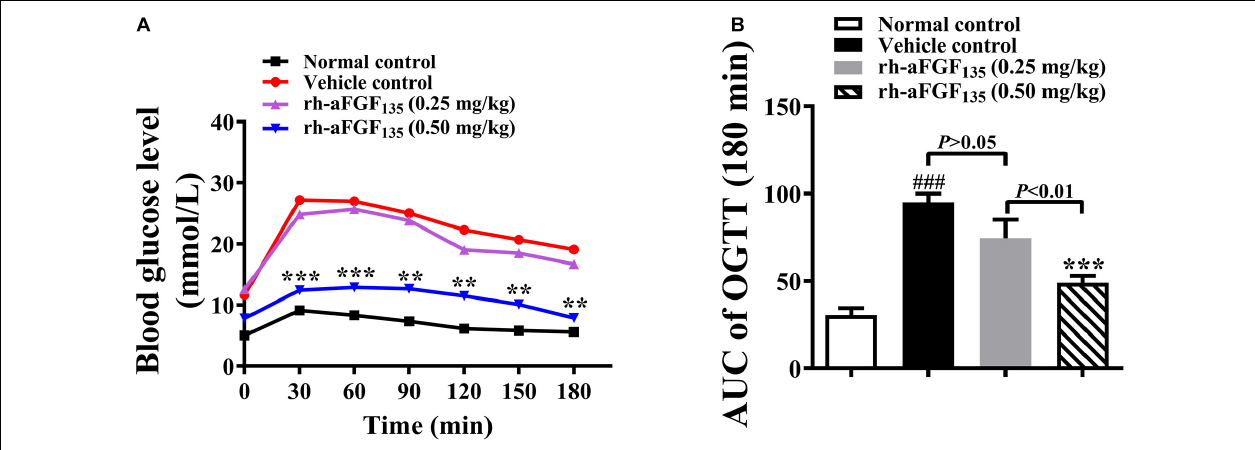
FIGURE 2 | Effect of rh-aFGF 135 on oral glucose tolerance in diabetic ZDF rats. (A) Blood glucose levels in OGTT. (B) AUC value of OGTT. Compared to normal control, ### P < 0.001; Compared to vehicle control, *** P < 0.001, ** P < 0.01, n = 6.